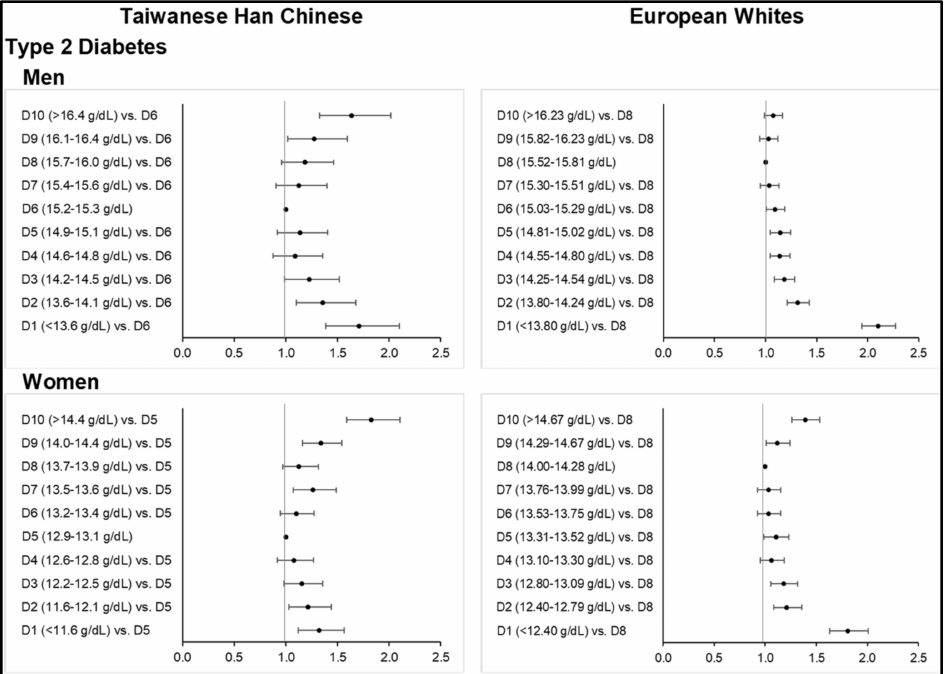
Figure 3. Odds ratios of diabetes across increasing deciles of hemoglobin concentration among Taiwanese Han Chinese and European Whites (top: men, bottom: women). Final models adjusted for age, age-squared, smoking status, alcohol consumption, physical activity level, highest educational attainment, and comorbidities, as well as menopausal status in